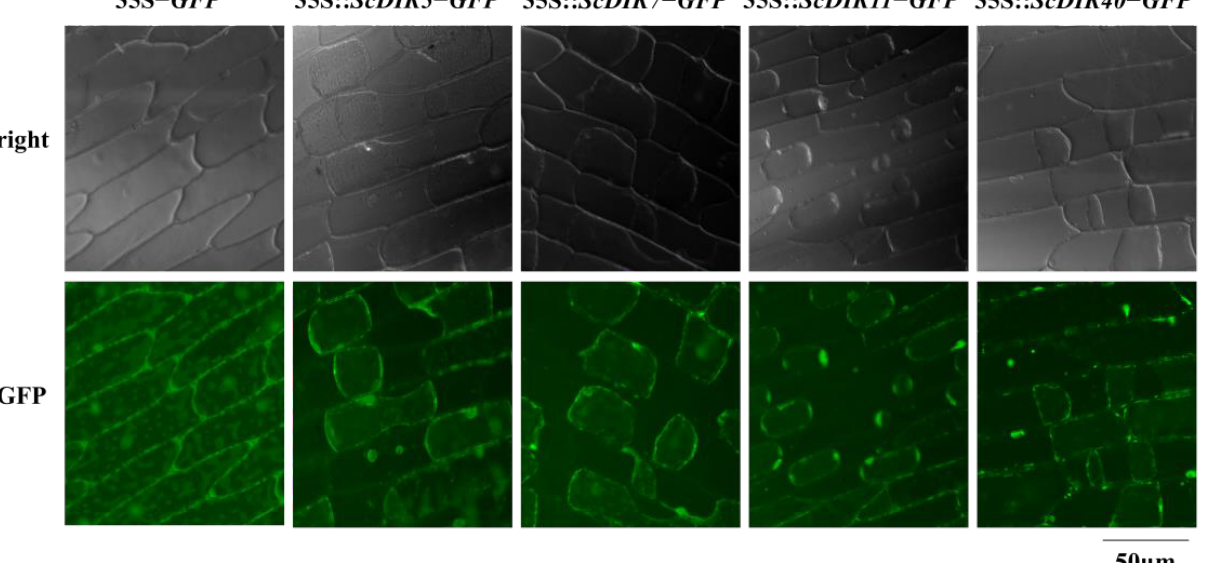
Figure 4. Transient expression of GFP fusion protein in onion epidermal cells. All constructs were driven by a 35S promoter. ScDIR − GFP , GFP fused with ScDIR at the C terminus. 2.5. Overexpression of ScDIR Genes Enhances Tolerance to Drought Stress in Transgenic Tobacco To further characterize the roles of ScDIR5 , ScDIR7 , ScDIR11 , and ScDIR40 in drought resistance, we expressed these genes in tobacco plants. Transgenic lines were selected for analysis (Figure 5). Leaves of the ScDIR7 − transgenic and ScDIR11 − transgenic tobacco plants exhibited increases in lignin content of 87–100% compared with the wild type. Although the lignin contents of ScDIR5 − transgenic and ScDIR40 − transgenic plants were lower, they were 1.3 times higher than those of wild − type plants (Figure 6). These results establish a positive correlation between ScDIR expression and the lignin content of